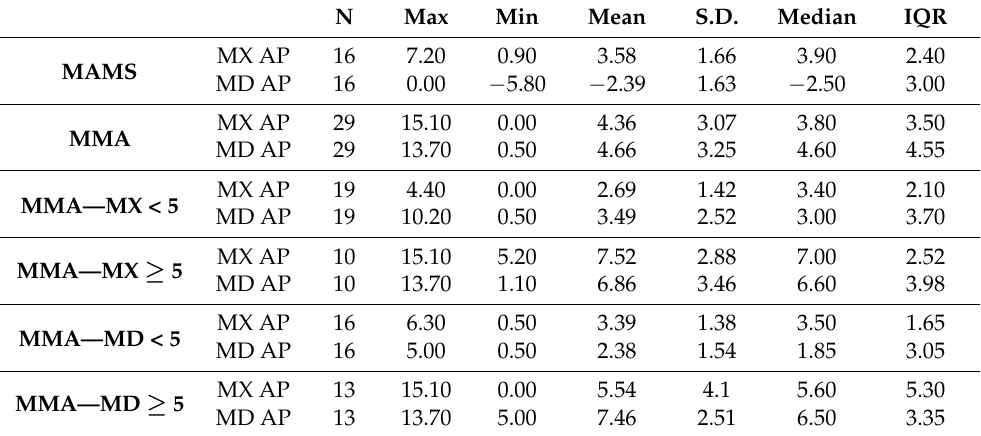
Table 1. Descriptive statistics of maxillary and mandibular displacement in each considered subgroup.